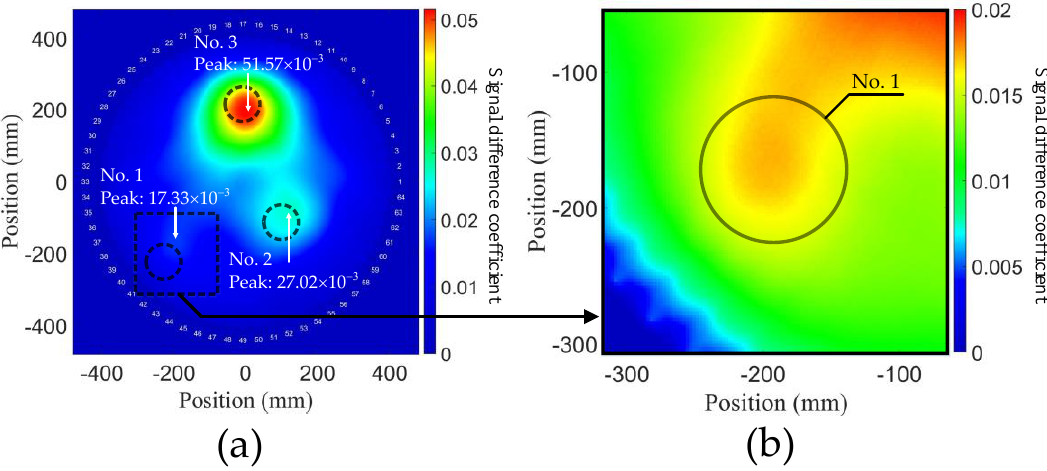
Figure 8. Probability distributions of aluminum plate model with early-life material degradations, using NGW method expressed with the second harmonics. ( a ) Reconstruction containing all degradations. The area covered by the circle corresponds to the positions of the three degradations in the FE model. ( b ) Zoom in on the square region around degradation No. 1 shown in ( a ).